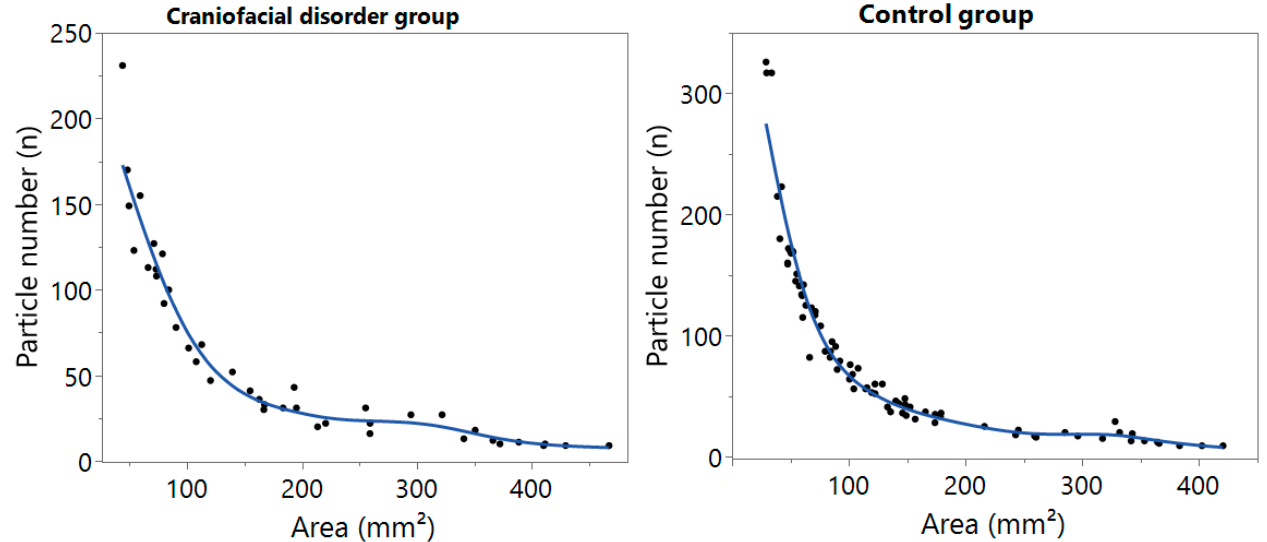
Figure 1. Masticatory efficiency curves comparing patients with craniofacial disorders (n = 42) and the healthy control group (n = 77). The obtained chewed particle number (n) is plotted against the obtained surface area (mm 2 ). Table 2. Results of masticatory efficiency for patients with craniofacial disorders (CD, n = 42) in comparison to the control group (n = 77) in different chewing cycles. Mean and standard deviation of particle number (n) and area (mm 2 ) was given for the different cycles. These are differentiated by the chewing side and employed sample body hardness: total (all nine chewing cycles), right/left/bilateral (three chewing cycles within each hardness level) and soft/medium/hard (three chewing cycles within each chewing side). Statistical significance was considered at p < 0.05 and denoted with (*). Particle Number (n)